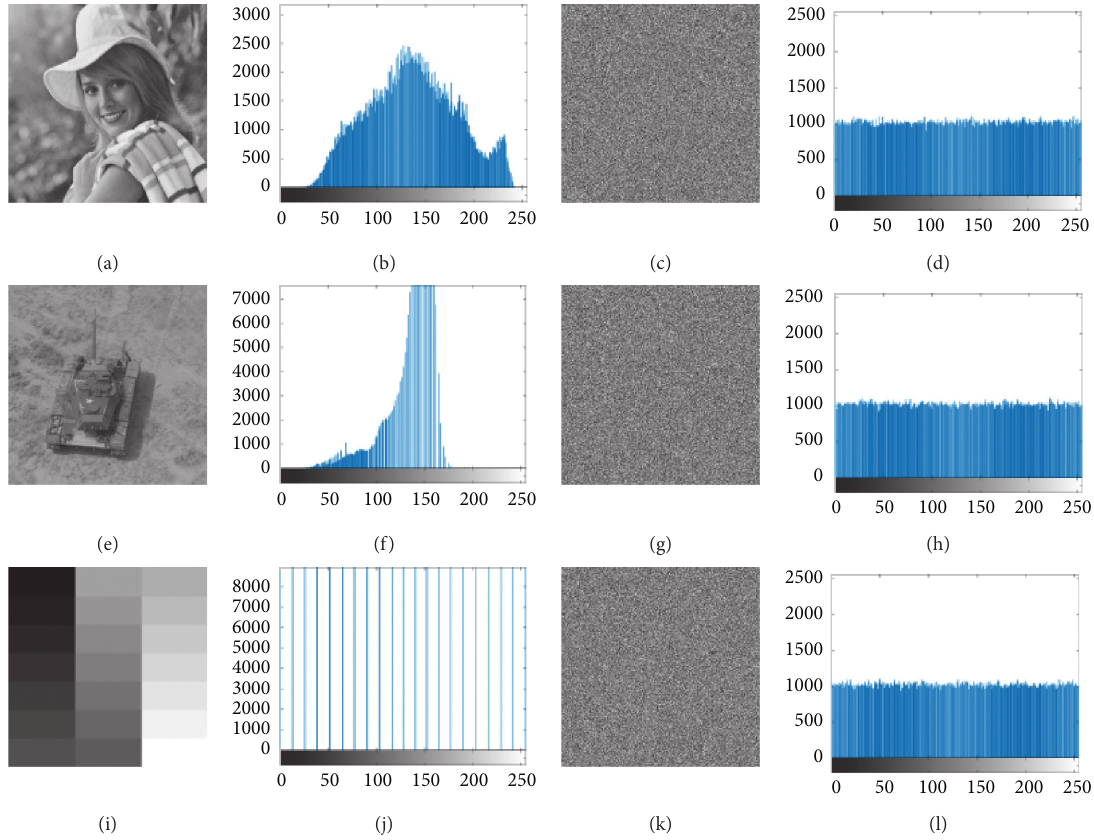
Figure 10: Pixel value distribution histograms of elaine.512.tiff, 7.1.03.tiff, gray21.512.tiff, and their corresponding cipher images: (a) elaine.512.tiff; (b) histogram of (a); (c) cipher image of (a); (d) histogram of (c); (e) 7.1.03.tiff; (f) histogram of (e); (g) cipher image of (e); (h) histogram of (g); (i) gray21.512.tiff; (j) histogram of (i); (k) cipher image of (i); (l) histogram of (k). Table 5: Histogram variance test results of some images.